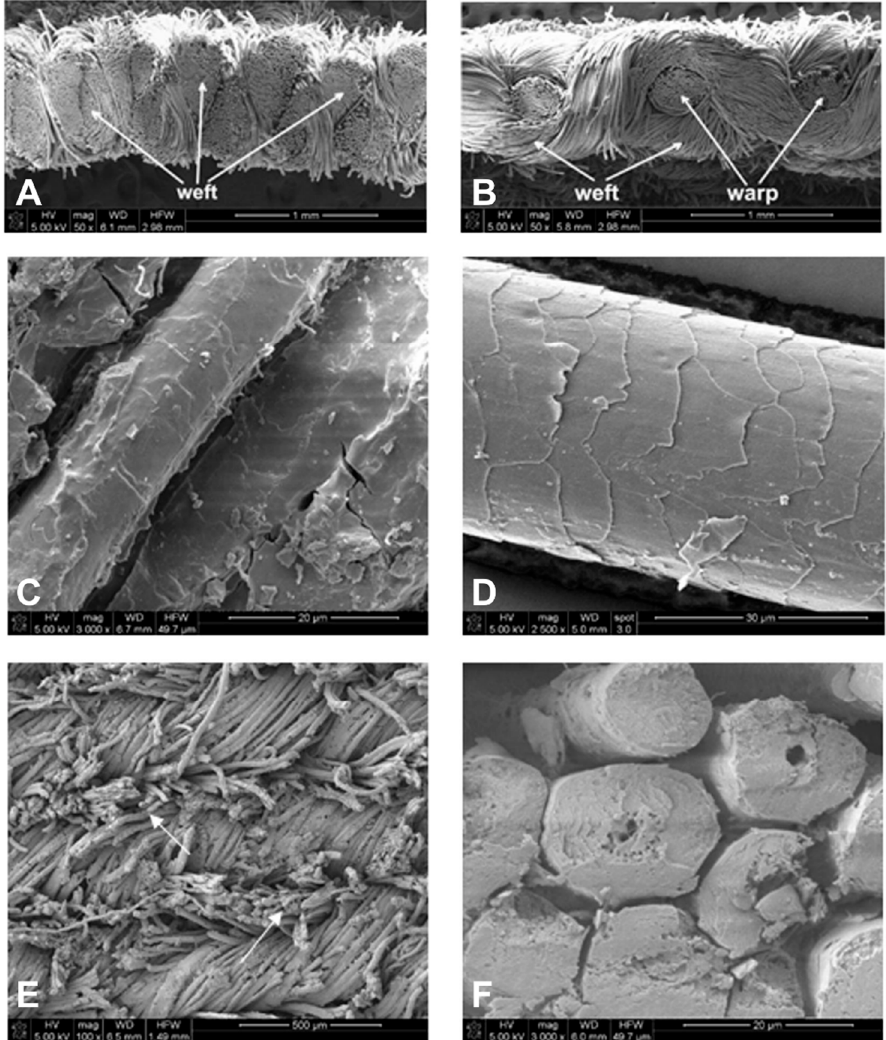
Figure 1. SEM images of the cross-section of the archeological fabric ( A,B ); fibers in archeological textile fabric ( C ); contemporary alpaca fibers ( D ); thread damages to archeological textile fabric ( E ); cross-section of the archeological fibers ( F ).